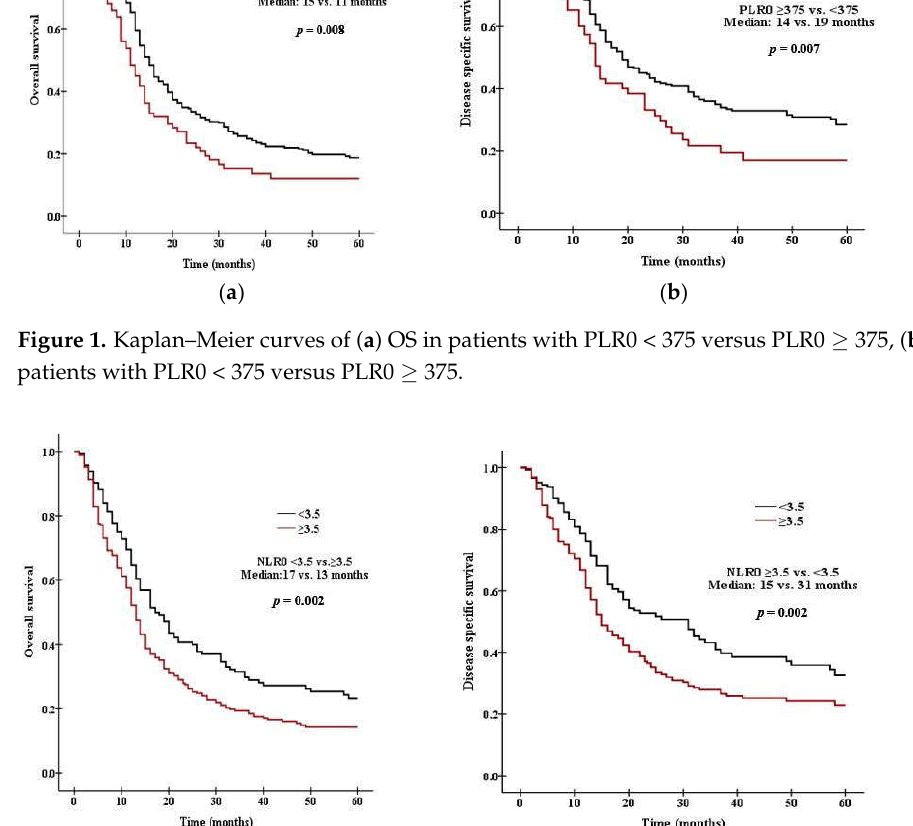
( b ) Figure 4. Kaplan–Meier curves of ( a ) OS in patients with NLR1/NLR0 ≥ 1 versus NLR1/NLR0 < 1, ( b ) DSS in patients with NLR1/NLR0 ≥ 1 versus NLR1/NLR0 < 1. 4. Discussion Definitive CCRT is an established management option for patients with locally ad- vanced esophageal cancer and the overall survival outcome of CCRT is comparable to that of preoperative CCRT plus surgery [4–6]. Some clinical factors have been used to predict outcome of esophageal cancer patients receiving CCRT. In our analysis of 420 patients with esophageal SCC who underwent CCRT, advanced age of ≥65 years old was not a significant factor for poor OS ( p = 0.308) and DSS ( p = 0.909). The result was compatible with a systemic review of outcome of elderly esophageal cancer patients. In this article, advanced age seems not to be an influencing factor for treatment outcome, although 22– 36% patients had CCRT toxicity grade of more than 3 [11].In our study, it was shown that ECOG performance status 1–2, clinical staging I-II, operation, and cisplatin dose >150 mg/m 2 were significantly associated with OS and DSS; furthermore, these four factors were independent predictors for OS and DSS on multivariate analysis (Table 2). Similar results were observed in a recent study of esophageal cancer patients undergoing CCRT